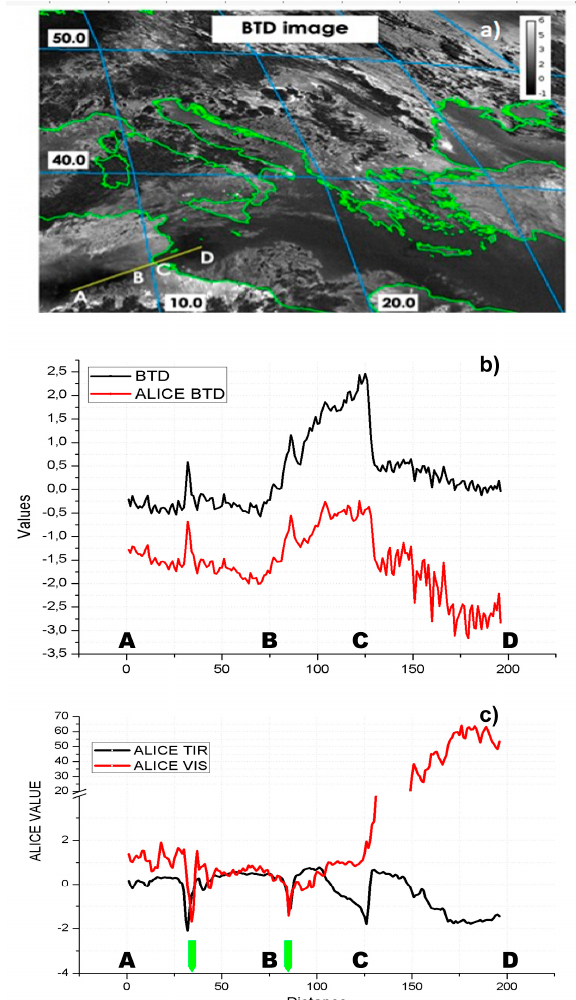
Figure 13. ( a ) BTD SEVIRI image of 12 May 2010 at 12:00 UTC and the A-B-C-D transect (in yellow) intersecting dust plume of Figure 12; ( b ) spatial profile of BTD signal (in black) and of ⊗ Δ TIR ( x,y,t ) index (in red); ( c ) spatial profile of ⊗ VIS ( x,y,t ) (in red) and ⊗ TIR ( x,y,t ) (in black) indices, with indication of land locations (green arrows) where e RST DUST did not detect airborne dust.